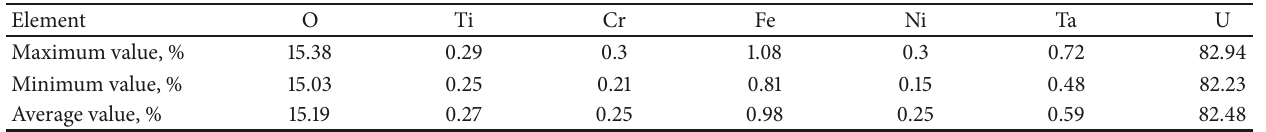
Table 2: Elemental analysis results.